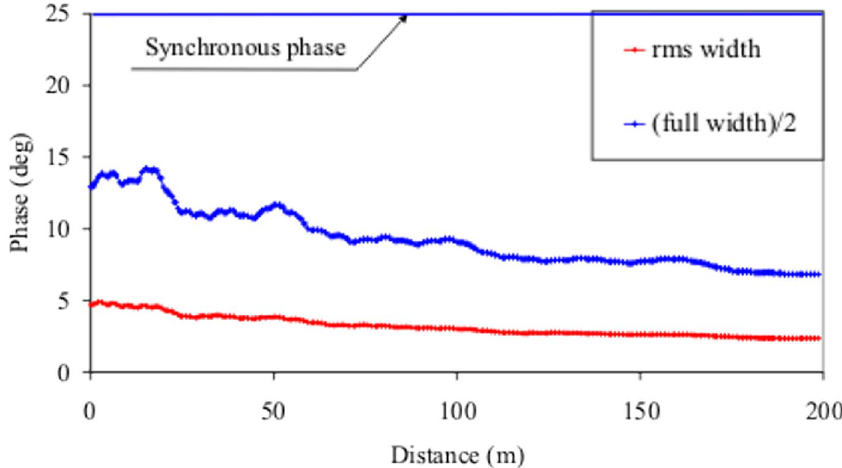
FIG. 6. (Color) Beam size in the longitudinal plane through the high- (cid:3) section of the triple-spoke cavity based linac. The lower curve is the rms size and the upper the maximum